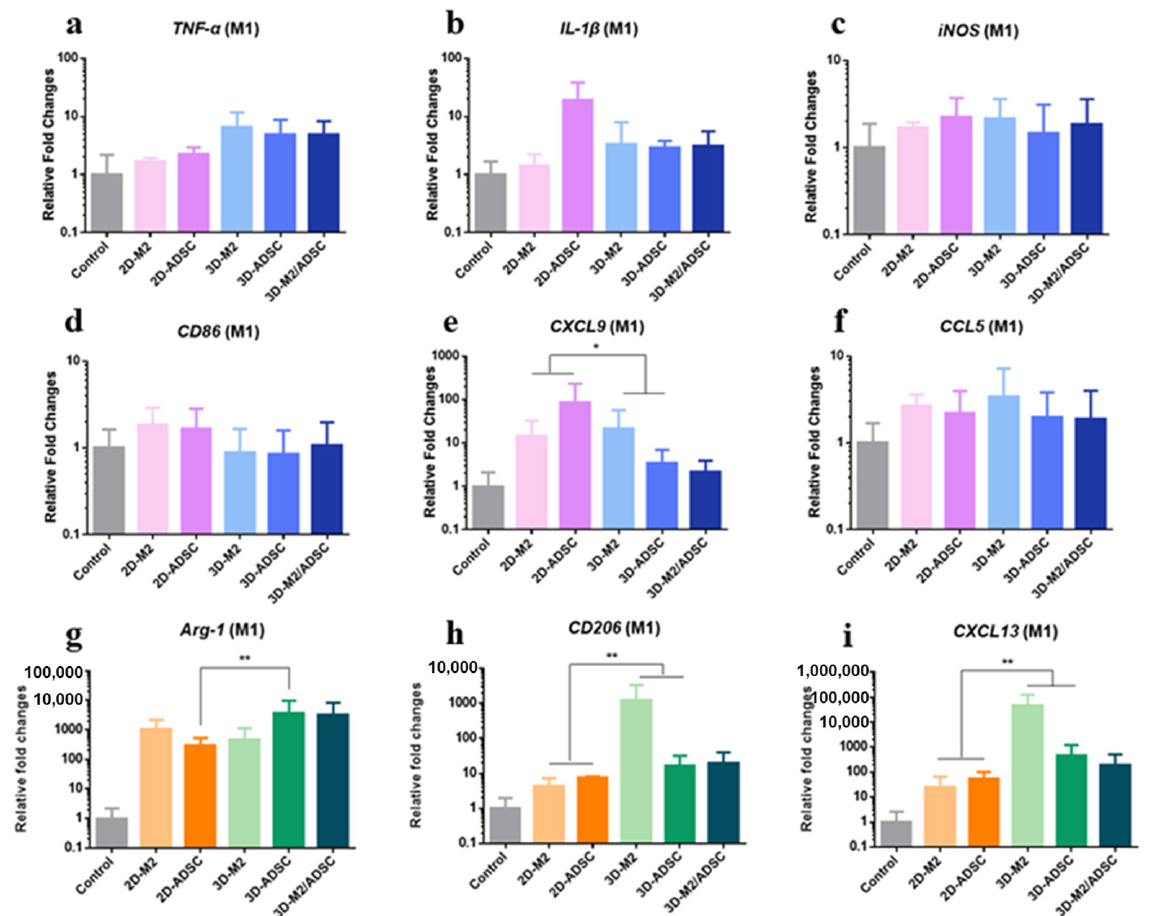
Figure 7. The qRT-PCR results of a classic cytokines expression from encapsulated RAW246.7 and ADSC cells into an in vitro wound model microenvironment: ( a ) TNF- α expression; ( b ) IL-1 β expression; ( c ) iNOS expression; ( d ) CD66 expression;( e ) CXCL9 expression; ( f ) CCL-9 expression; ( g ) Arg-1 expression; ( h ) CD206 expression; ( i ) CXCL13 expression. n = 3, * p < 0.05, ** p < 0.01. 2.8. Effects of a Paracrine Entity on Cell Migration in an In Vitro Epithelial Recovery